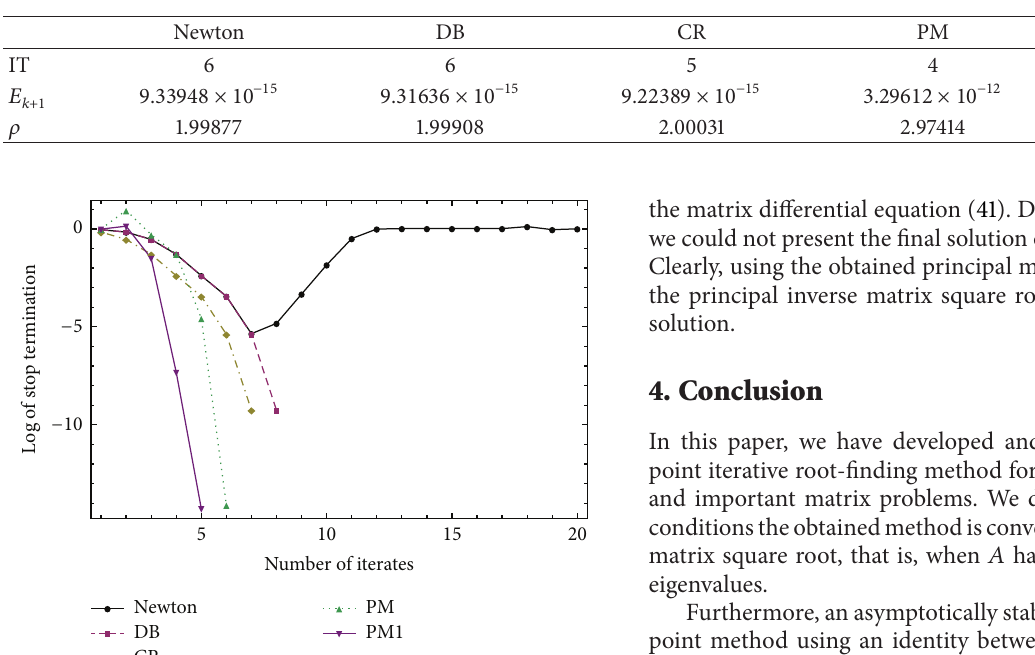
Table 1: Results of comparisons for Example 7.